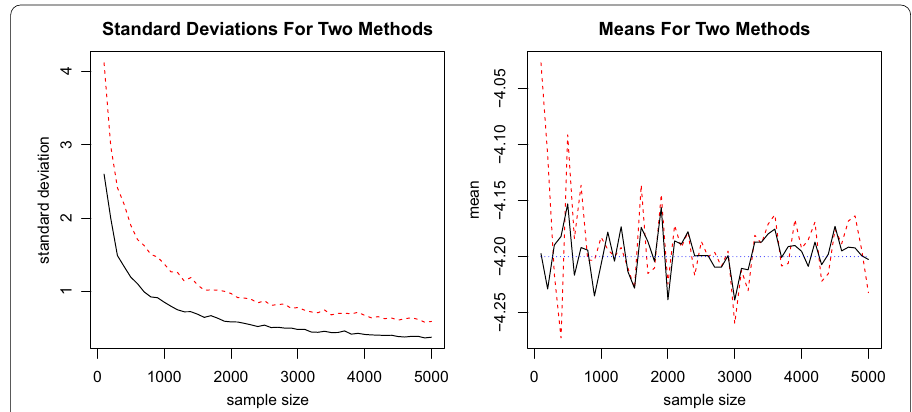
M 1 (τ , σ) are in dashed (red) line and the ones for M 2 (τ , σ) are in solid 0.01 . Results for = 0.4011 and ρ 0.7596 . The dotted (blue) line = = − M 2 (τ , σ) based on a sample of size N 2 10 (cid:31) (cid:31) = (cid:31)